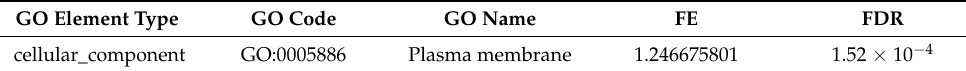
Table 3. Enrichment Analysis for Cluster 1.